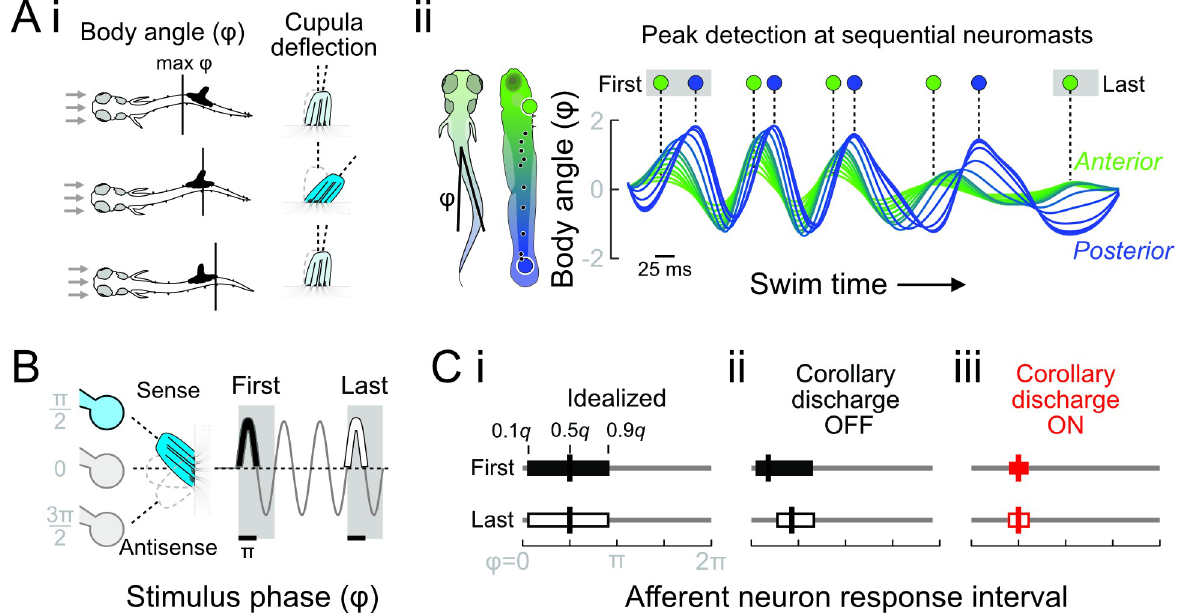
Fig 2. Effects of undulation, adaptation, and CD on signaling of reafference in the lateral line. (A) (i) Larval zebrafish swimming is characterized by body undulations that induce periodic reafference in the lateral line. The instantaneous body angle at each neuromast ( ϕ ) depends on body wavelength and frequency. In the quasi-steady approximation, the body wave passing a neuromast dictates the timing of maximum cupular deflection (denoted by intense blue). (ii) The timing of the body wave peak from the first to last tail beats is shown at the locations of the most rostral (green) and most caudal (blue) neuromasts. (B) Neuromasts were stimulated by a dipole piezo stimulus to examine afferent neural responses from the first to last stimulus period. In hair cells’ sense direction, the peak of feedback is expected to coincide with maximum stimulation at phase π /2 (denoted by intense blue). (C) Polarized hair cells have a maximum signaling phase of a half stimulus cycle. (i) An idealized sensor maintains a proportional output between deflection and output throughout the stimulus bout. The response interval is therefore constant, as reported by the quantiles ( q ) of afferent spike phase with respect to the stimulus ( ϕ ). Thick vertical lines denote the median spike phase. (ii) In real sensors, we observe adaptation from the first to last stimulus intervals. We predict this leads to decreased sensitivity and thus distorted response intervals and increased VS. Peak reafference precedes π /2 and changes over time, so cannot reliably signal body wave progression. (iii) CD (ON) reduces hair cell sensitivity during motor bouts, so hair cells provide feedback only to the strongest cupular deflections coinciding with the passage of the body wave. CD thus restructures afference to reliably signal motor phase throughout the motor bout. CD, corollary discharge; VS, vector strength.